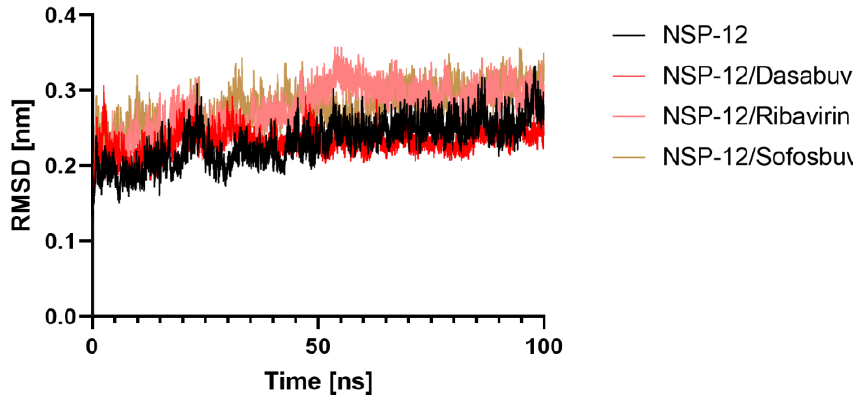
Figure 5. Structural stability analysis. RMSD of protein backbone vs. simulation time for solvated NSP-12 protein in complex with Dasabuvir, Ribavirin, and Sofosbuvir during 100 ns of molecular dynamics simulations.